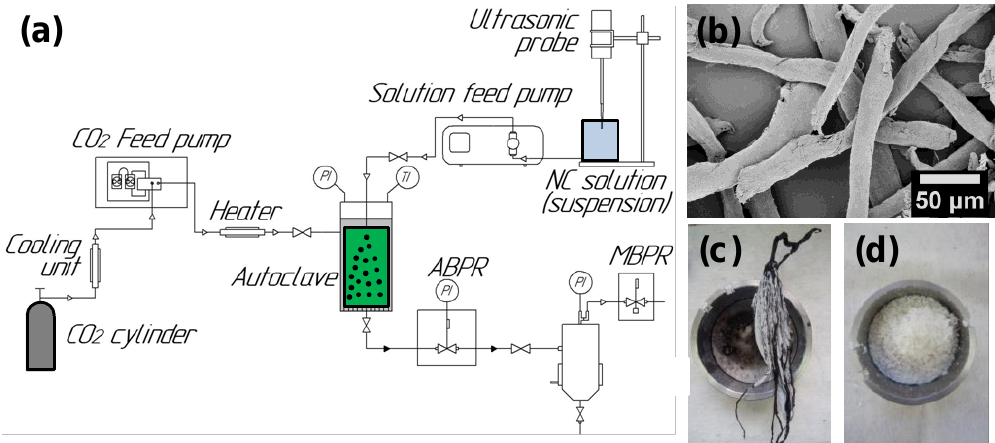
Figure 1. Supercritical anti-solvent (SAS) fabrication of nitrocellulose (NC)-based composites: ( a ) scheme of the experimental setup, ( b ) scanning electron microscopy (SEM) of raw NC fibers, ( c ) product obtained under non-optimized conditions, ( d ) pure NC after SAS treatment in optimized conditions.